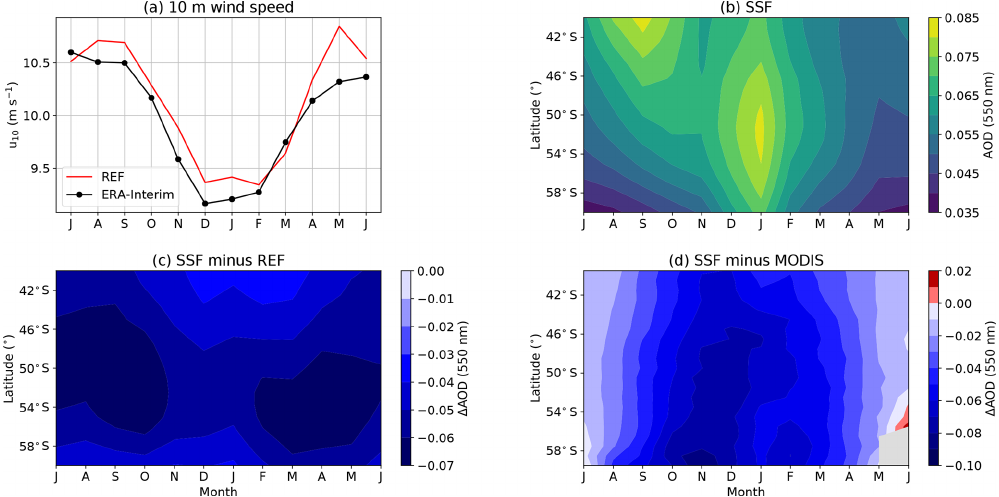
Figure 3. (a) Near-surface (10m) climatological monthly-mean wind speed between 40 and 60 ◦ S in the REF simulation and ERA-Interim reanalysis between 2003 and 2007. (b) Monthly-mean AOD in the SSF sensitivity simulation with the SSA source function changed to that of Hartery et al. (2019). (c) AOD difference between the REF and SSF simulations. (d) AOD difference between MODIS and the SSF simulation.